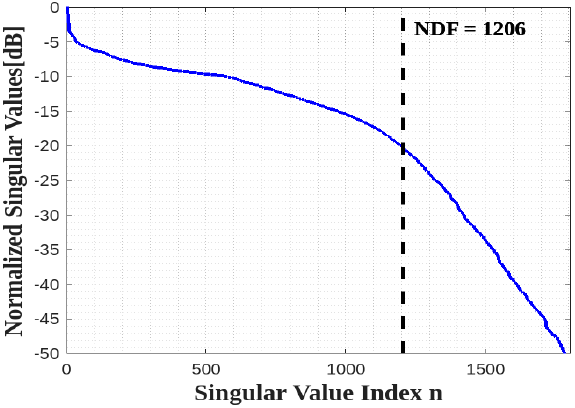
Figure 8. The behavior of normalized singular values for XY and XZ planes as an L shape.